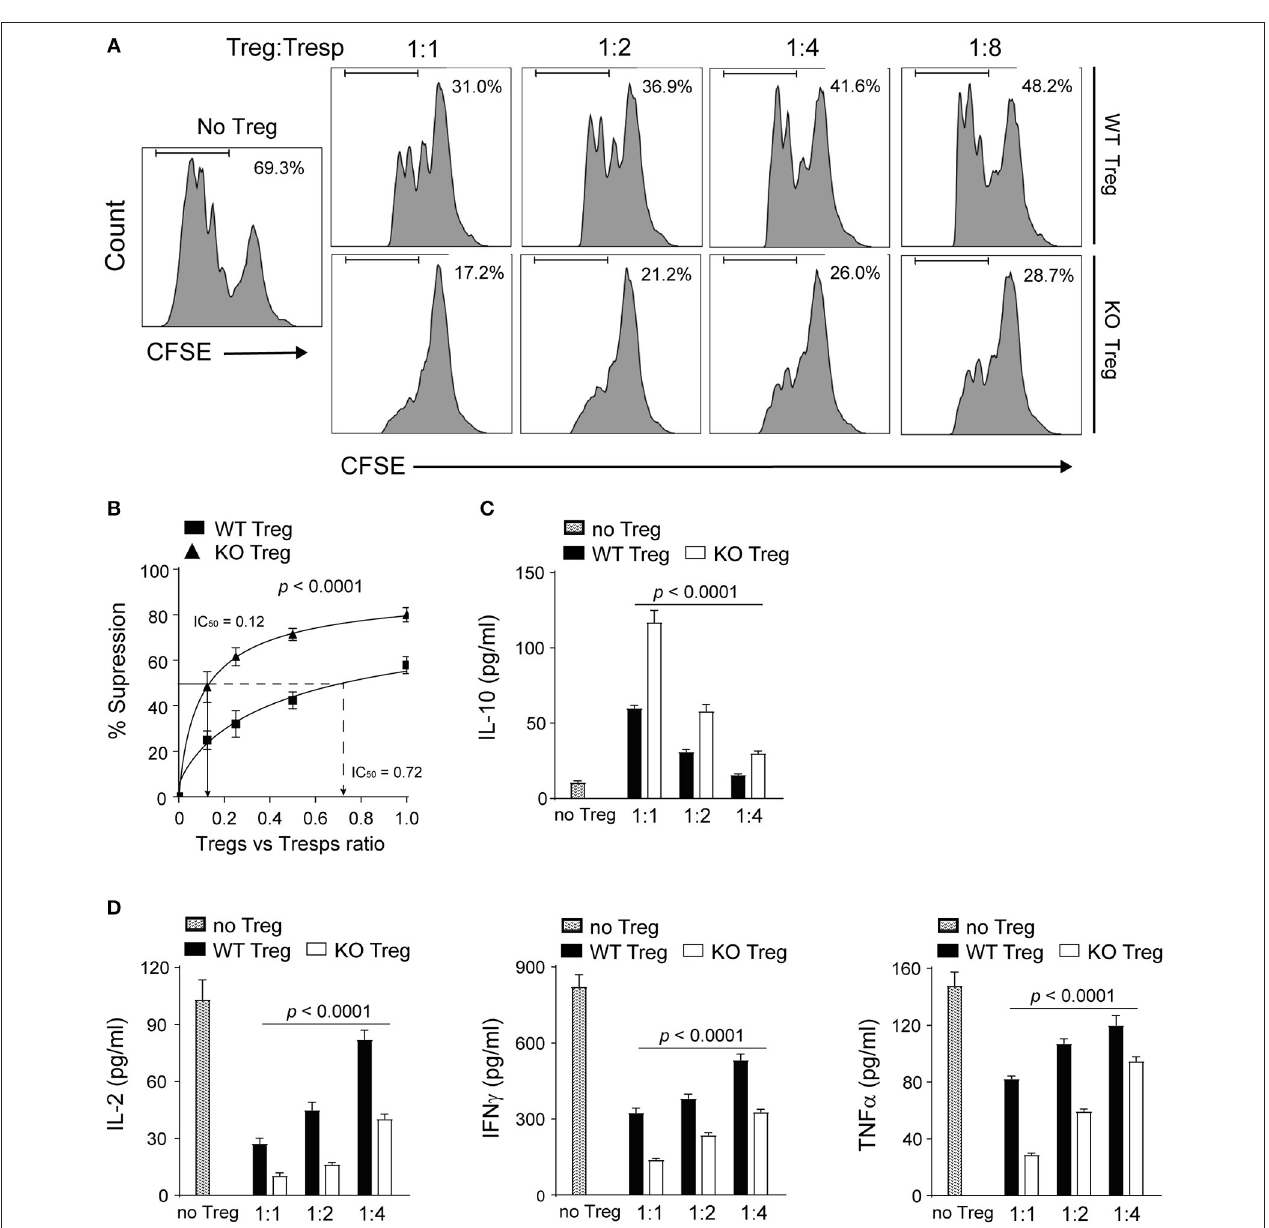
FIGURE 3 | Absence of PAR4 leads to the enhanced suppressive capacity of Tregs. CD4 + CD25 + Tregs from WT spleen and pLN were purified and co-cultured with PAR4ko Tresps and APCs in the presence of anti-CD3 for 72h. Representative histograms showing the CFSE dilutions of Tresps cultured alone (No Tregs) or with different numbers of WT or PAR4ko Tregs (A) . Pooled data showing the percentages of suppression of WT and PAR4ko Tregs [ p < 0.0001; (B) ]. IC50 values representing the Treg:Tresps ratio required to achieve 50% suppression are shown for the PAR4ko (triangles) and WT (squares) Tregs. Graphs show mean ± SEM from six experiments. Data were analyzed by two-way ANOVA to compare between these two Treg groups. CBA analysis of cytokines IL-10 [ p < 0.0001; (C) ] and IL-2, IFN γ , and TNF α [ p < 0.0001; (D) ] in the supernatants obtained from six suppression assays. Graphs show mean ± SEM from four experiments. Data were analyzed by two-way ANOVA to compare between these two Treg groups with a sequential dilution.